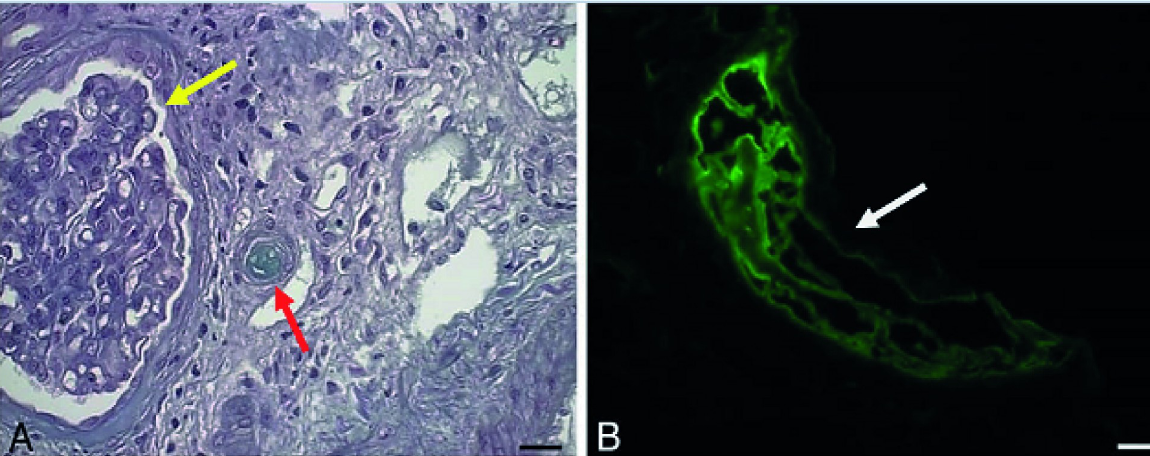
Fig 1. Renal biopsy findings in the patient of the case 1. (A) Glomeruli relatively spared (yellow arrow) and an adjacent arteriole with luminal thrombi (red arrow)—Masson’s trichrome. (B) Fibrin in arteriole wall detected with antibody to fibrinogen is shown (white arrow)—direct Immunofluorescence. Bars (A, B) = 15 μ